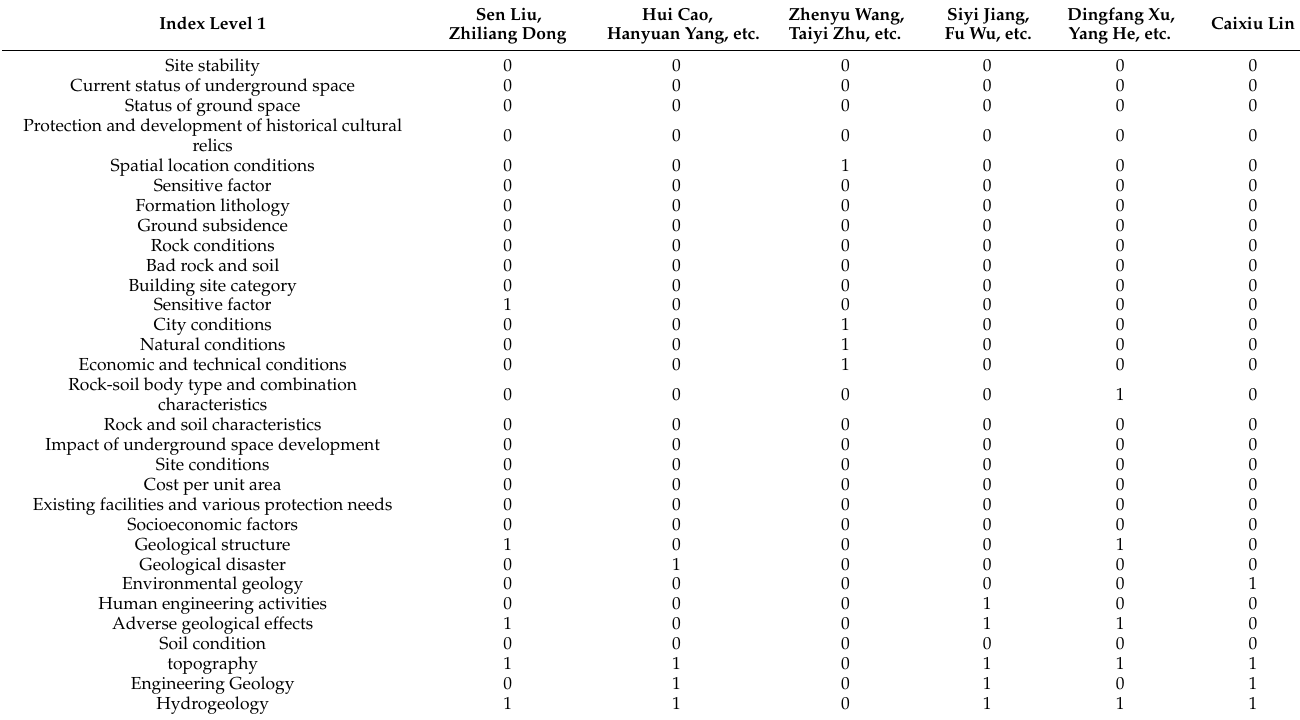
Table A4. First level index binarization matrix.